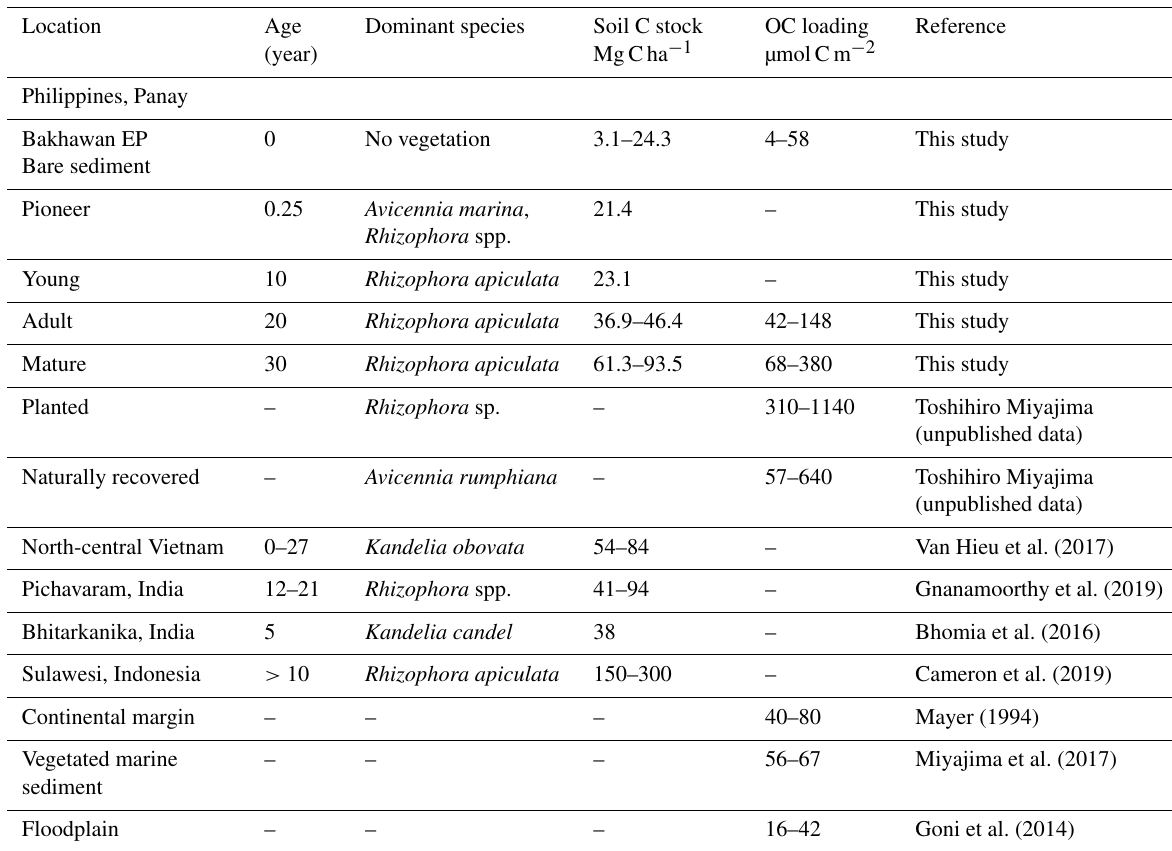
Table 3. Comparative results on carbon stocks (MgCha − 1 ) in restored mangroves of known ages and organic carbon loading (µmolCm − 2 ) in mangroves with other marine